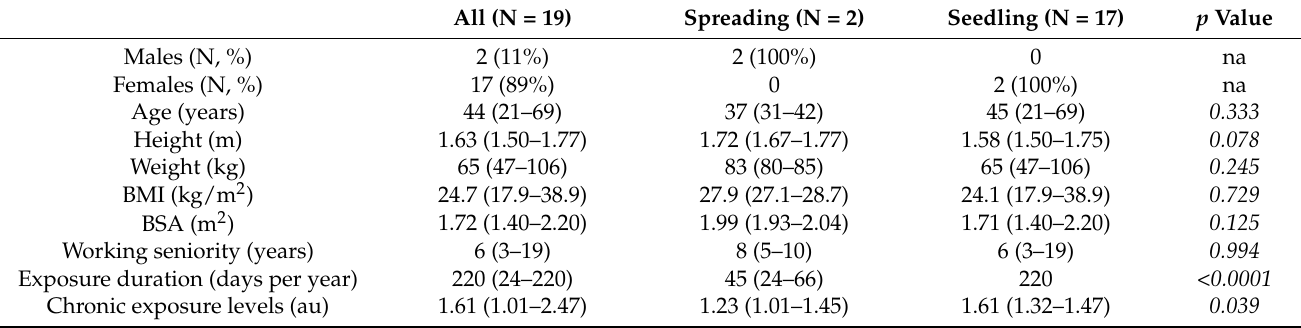
Table 1. Characteristics of the workers enrolled in the study and relative chronic exposure